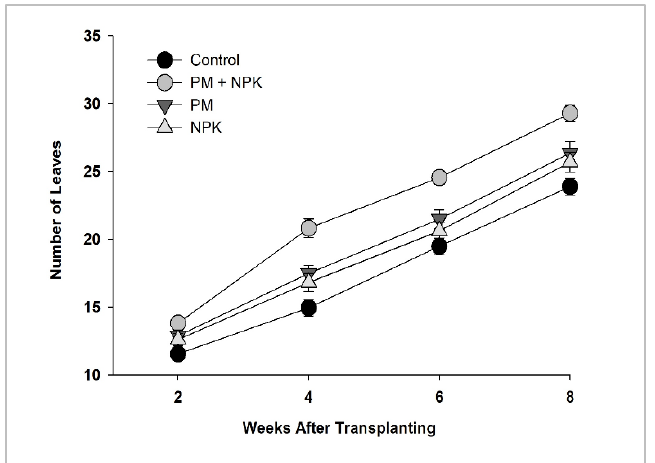
Figure 3 : Effect of inorganic and organic fertilizer on the number of leaves of cabbage